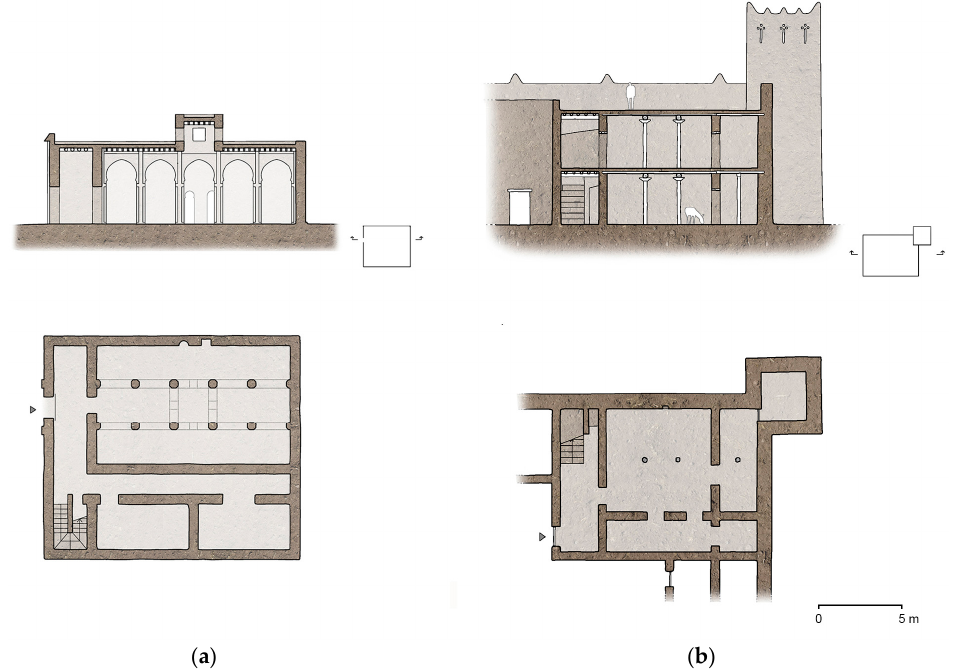
Figure 7. Graphic survey: ( a ) Tizuka Mosque, (Mdagra Oasis); ( b ) Dwelling at the Smoura Ksar (Outat Valley).